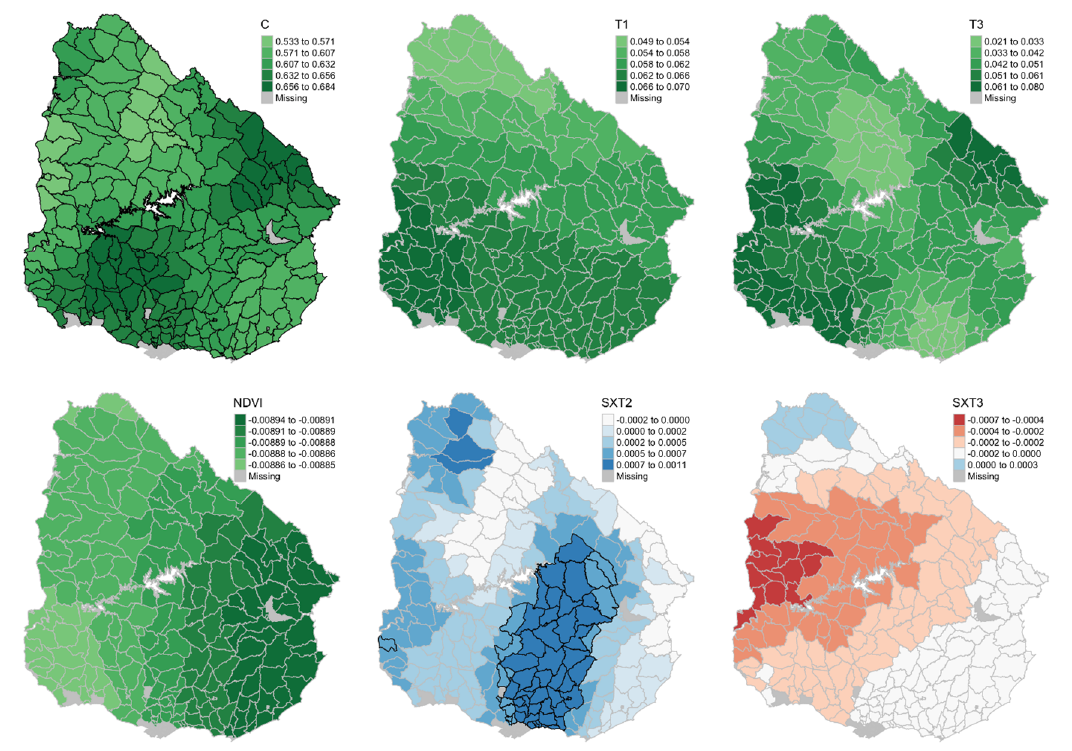
Figure 3. SVCs for temporary agro-ecological conditions: The intercept (C), T1 (summer), T3 (winter), NDVI (pasture condition), the interaction between SWR (surface water runoff) and T2 (fall) (SXT2), and the interaction between SWR and T3 (summer) (SXT3). The SVCs are shown with their significance from zero by highlighting the border of their areal unit (otherwise not significant at 5% level) and have all been corrected for multiple comparisons.